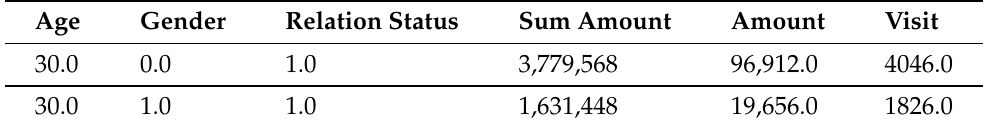
Table 11. Need based Package for Categoy G.